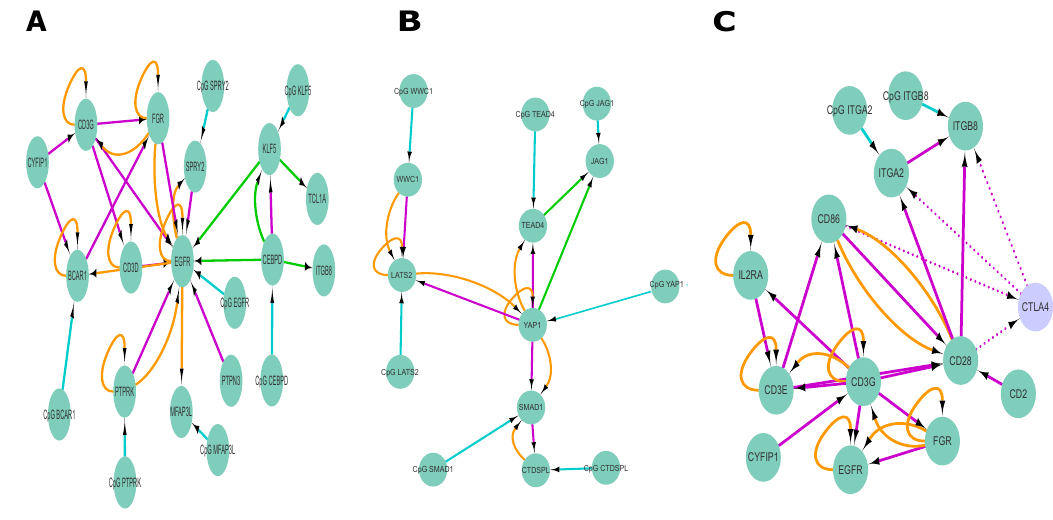
Figure 5. Genomic interaction network modules for cluster 7 (lymphoid neoplasm). ( A ) Subnetwork for the genes connected to EGFR. ( B ) Subnetwork for the region of genes connected to YAP1, TEAD4, JAG1, and SMAD1. ( C ) Subnetwork for the set of genes connected with CD28, CD86, and CTLA4. CTLA4 is a seeding node which is highlighted by the light color and the dotied interactions. Gene–gene interactions are shown in orange, DNA promoter region–gene interactions in cyan, protein–protein interactions in purple, and transcription interactions in green (activation) or red